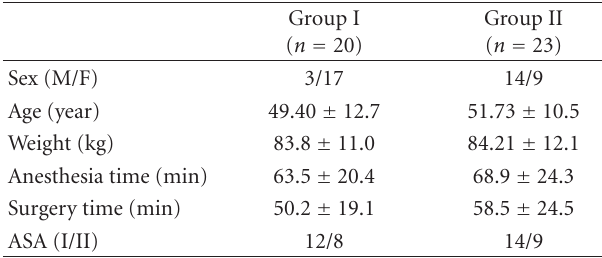
Table 1: Demographic